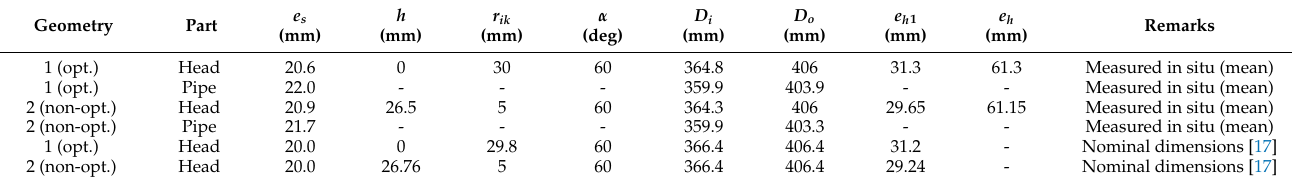
Table 1. Measured and nominal dimensions of tested flat ends with stress relief grooves.